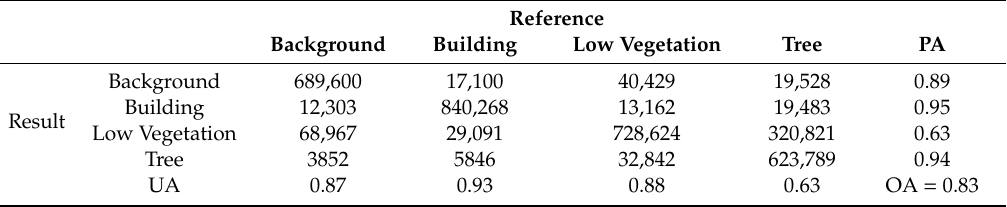
Table 6. Confusion matrix of SRM CNN result for Vahingen Dataset.